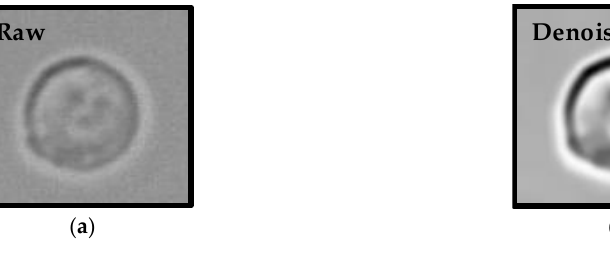
Figure 5. ( a ) A bright field image of MCF-7 cells and ( b ) the image after denoising.